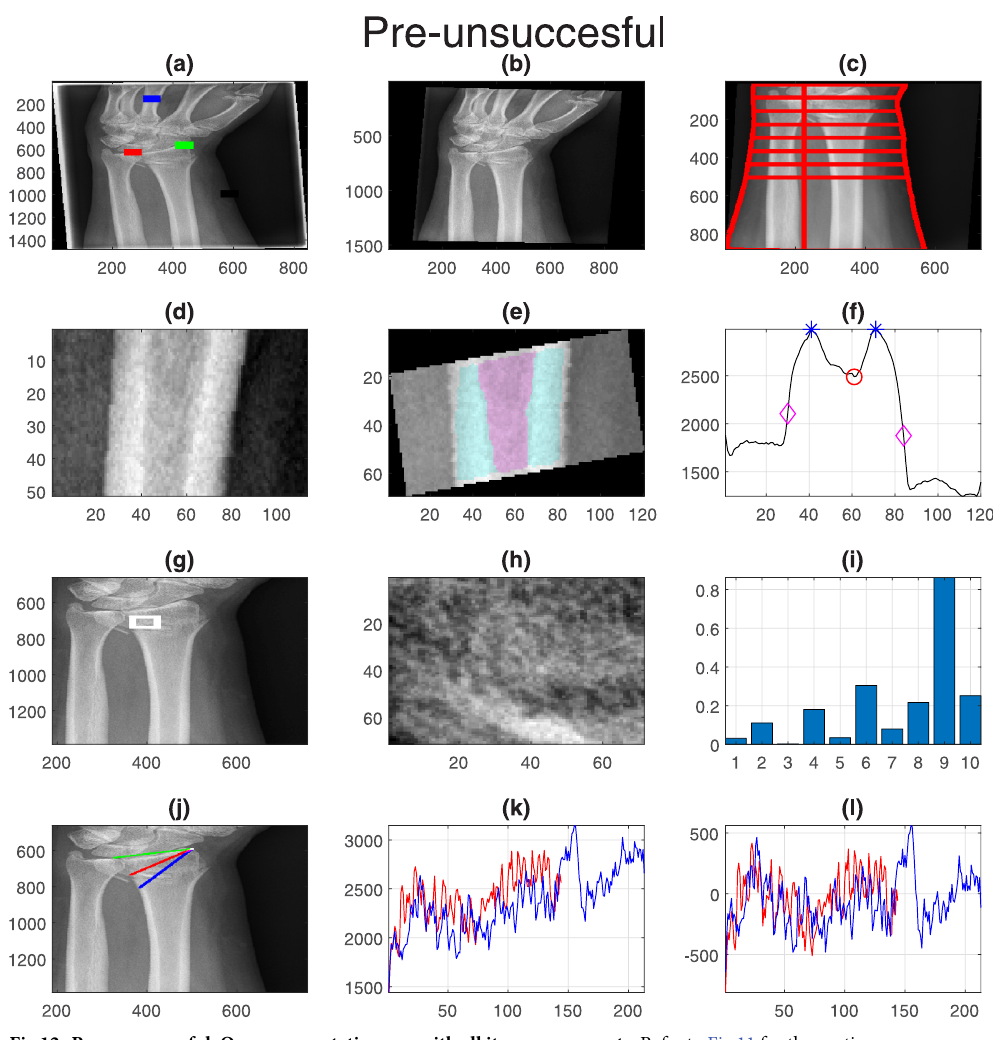
Fig 12. Pre-unsuccessful: One representative case with all its measurements. Refer to Fig 11 for the caption. were validated visually. It should be highlighted that there was a considerable variation in the quality of the images. However, this did not affect the measurement extraction. Namely, labels such as those visible in Fig 6 and the presence of plaster casts did not affect the methodology. No measurement indicated a statistical difference between the following groups: successful and unsuccessful, pre-intervention successful and pre-intervention unsuccessful, post-inter- vention successful and post-intervention unsuccessful. However, numerous measurements were statistically different between the groups: healthy controls and patients, pre-intervention and post-intervention for successful, unsuccessful and combined. The differences between healthy controls and patients could be expected due to many factors, such as the age of the patients being higher than the controls. Within the patient groups, the texture features, both those extracted from the profile lines as the LBP features, showed a statistical difference between controls and patients, as well as between x-rays of pre- and post- intervention. Twenty-five of the 32 measurements indicated statistical differences between controls and